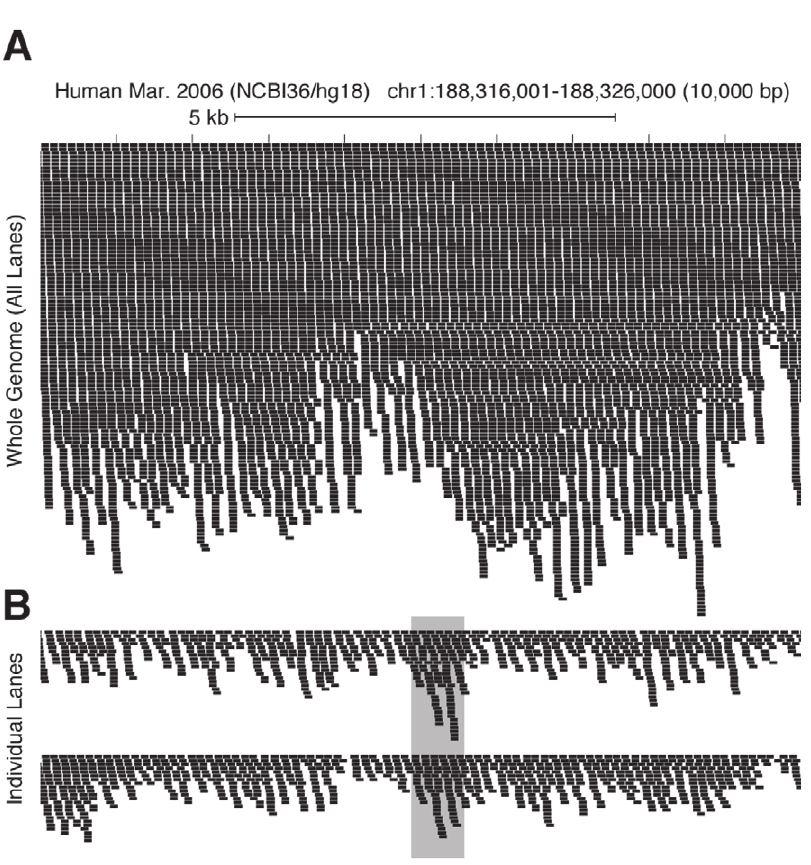
Figure 1. Overview of approach. Several lanes of HiSeq 2000 data are typically combined together for a comprehensive genome analysis, giving a high depth of coverage (A), and the ability to accurately call genotypes in the majority of the genome. In (B), two individual lanes of HiSeq 2000 data are depicted, with a lower average depth of coverage. By chance, some regions of the genome have enough data to be genotyped in both lanes (shaded gray).